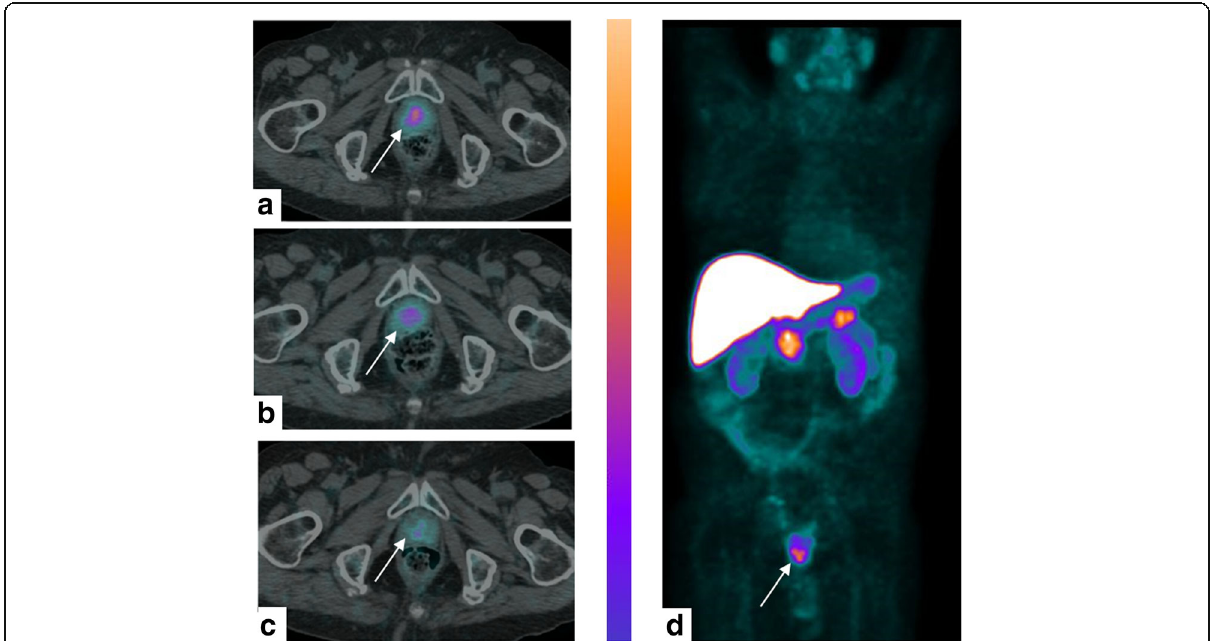
Fig. 2 An 85-year-old man affected by Gleason 4+3 PCa treated with EBRT, with rising PSA level (6.0 ng/mL) and PSA doubling time of 15 months. 64 CuCl 2 -PET/CT images (axial and MIP) revealed focal and pathologic tracer uptake (arrows) in correspondence to the prostate apex close to the midline 1 h after the injection ( a ). An important reduction of tracer uptake was observed 4 ( b ) and 24 h ( c ) after the injection. Maximum intensity projection ( d ) visualized the differences in terms of uptake between the organsand prostate relapse